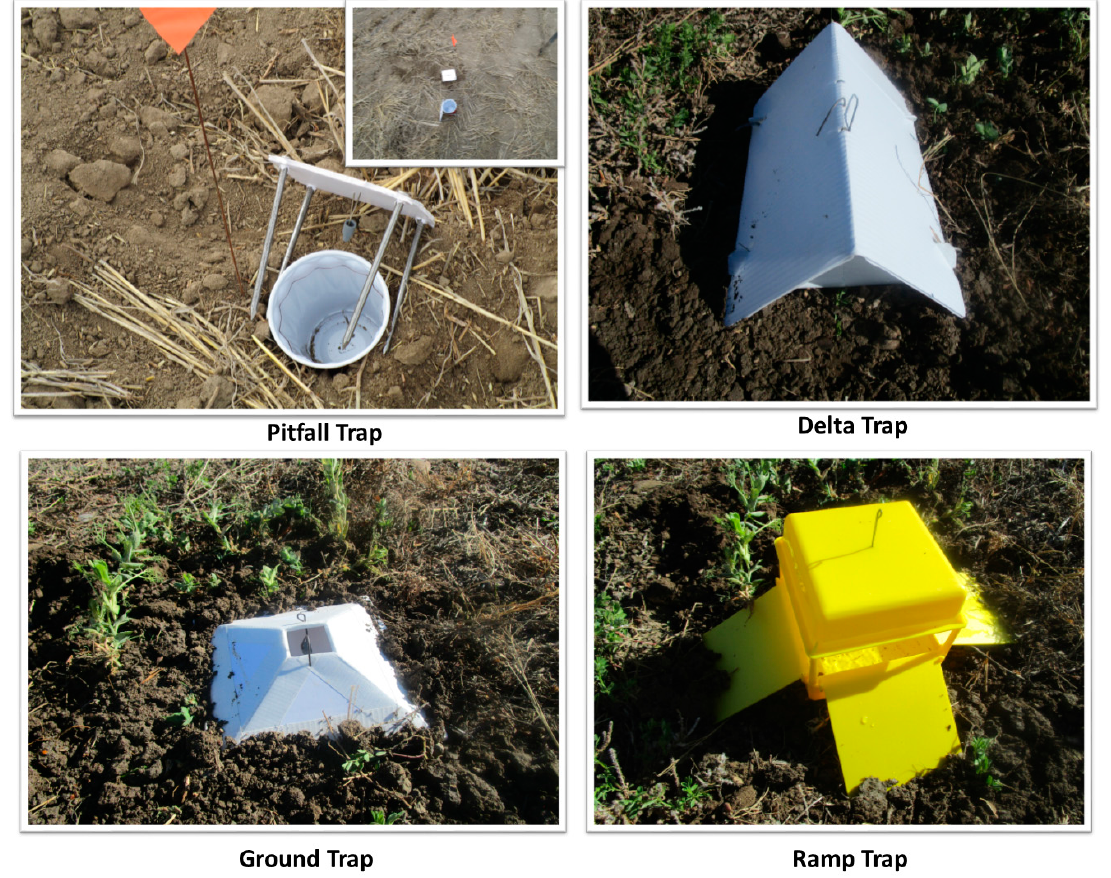
Figure 2. Trap types (pitfall, delta, ground and ramp traps) used to evaluate the most effective trap design in capturing the pea leaf weevil, Sitona lineatus.